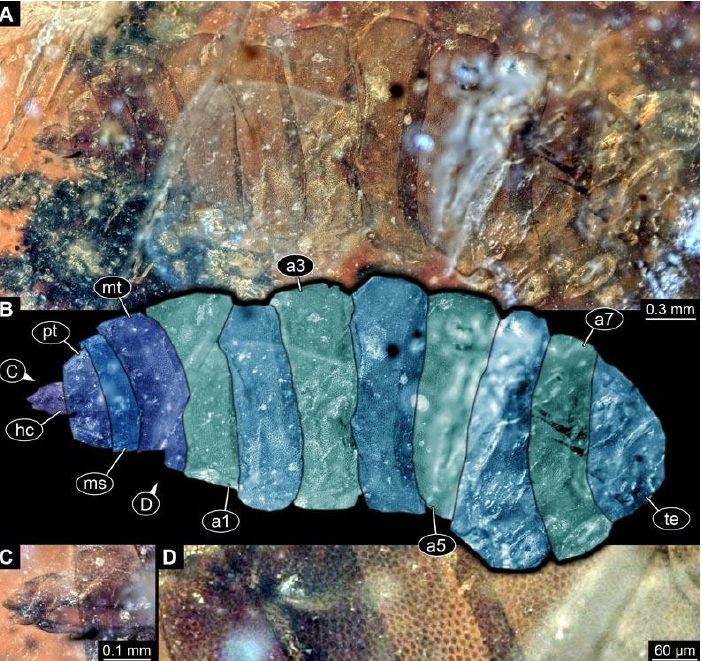
Figure 22. Fossil larva of morphotype 2 or 7, specimen PED 0593. ( A ). Full view of specimen. ( B ). Colour-marked. ( C ). Close-up of head capsule. ( D ). Close-up of surface structure. Abbreviations: a1 – a7 = abdomen units 1 – 7; hc = head capsule; ms = mesothorax; mt = metathorax; pt = prothorax; te = trunk end. (122) PED 0730: Specimen accessible in dorsal view (Figure 23). Numerous particles and bubbles conceal details, surface structure apparent. Head capsule well preserved. Di-